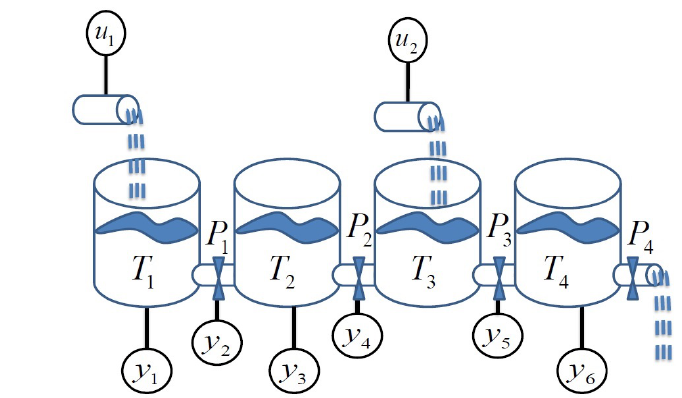
Figure 1. Running example: four-tank